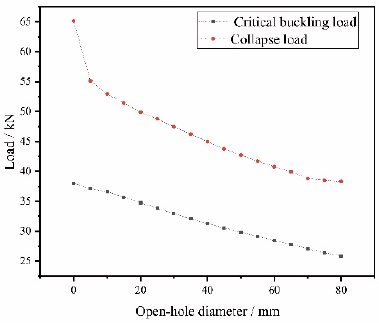
Figure 35. The critical buckling loads and the collapse loads of the composite beams’ FE models with the centered open-holes of different diameters.